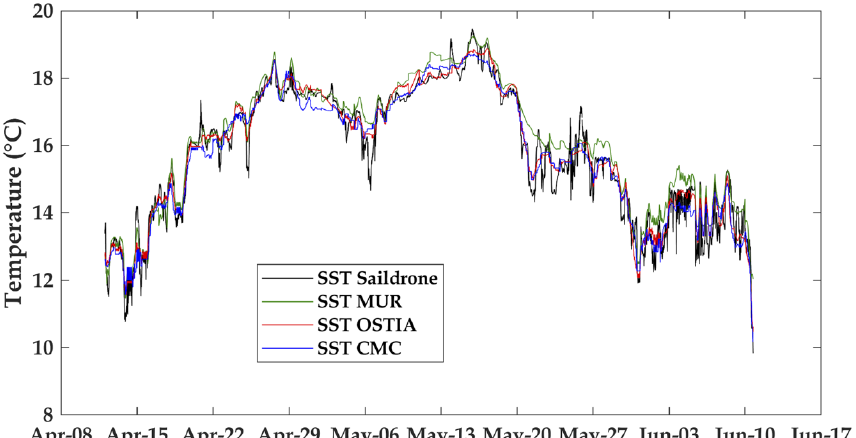
Figure 3. SST time-series from Saildrone CTD, MUR, OSTIA, and CMC. MUR, OSTIA, and CMC are co-located to the Saildrone track.